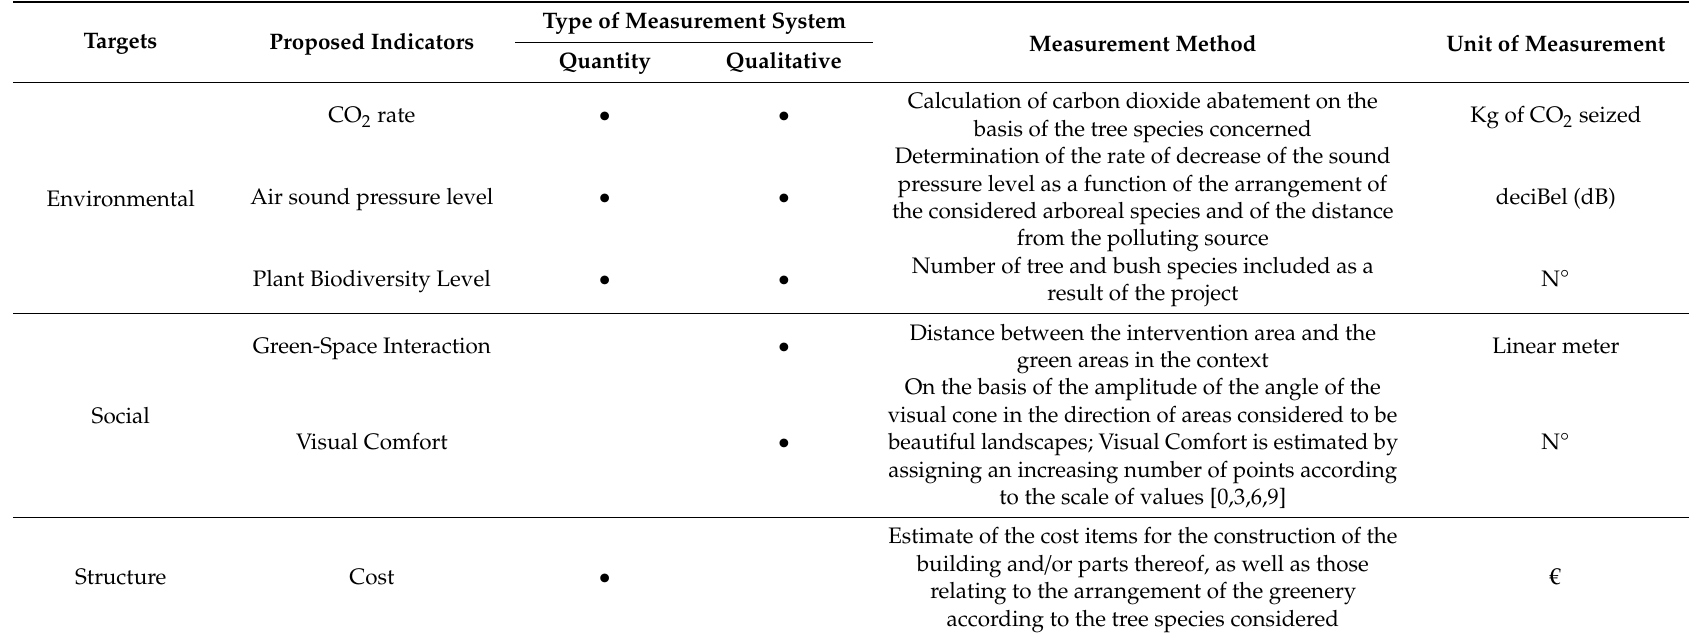
Table 3. Set of indicators for Integrated Ecosystem Projects